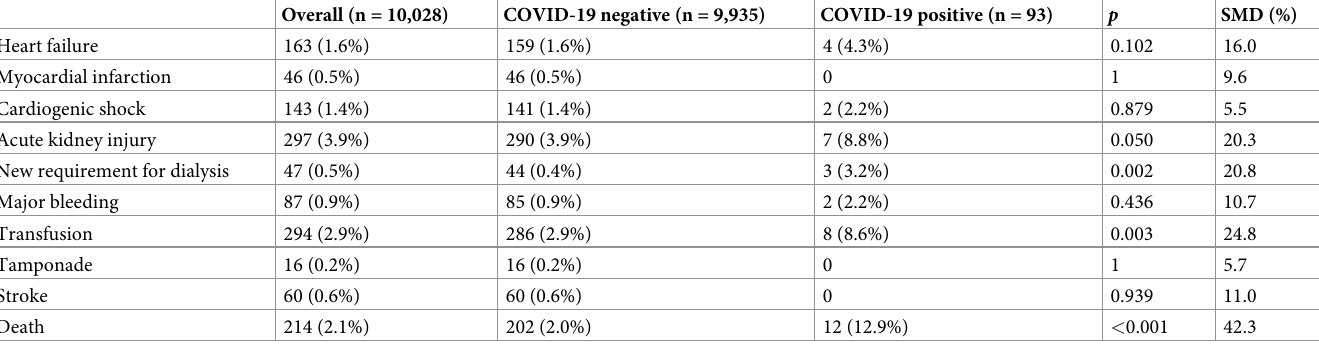
Table 4. In-hospital outcomes in patients with a positive vs. negative COVID-19 test in the pandemic